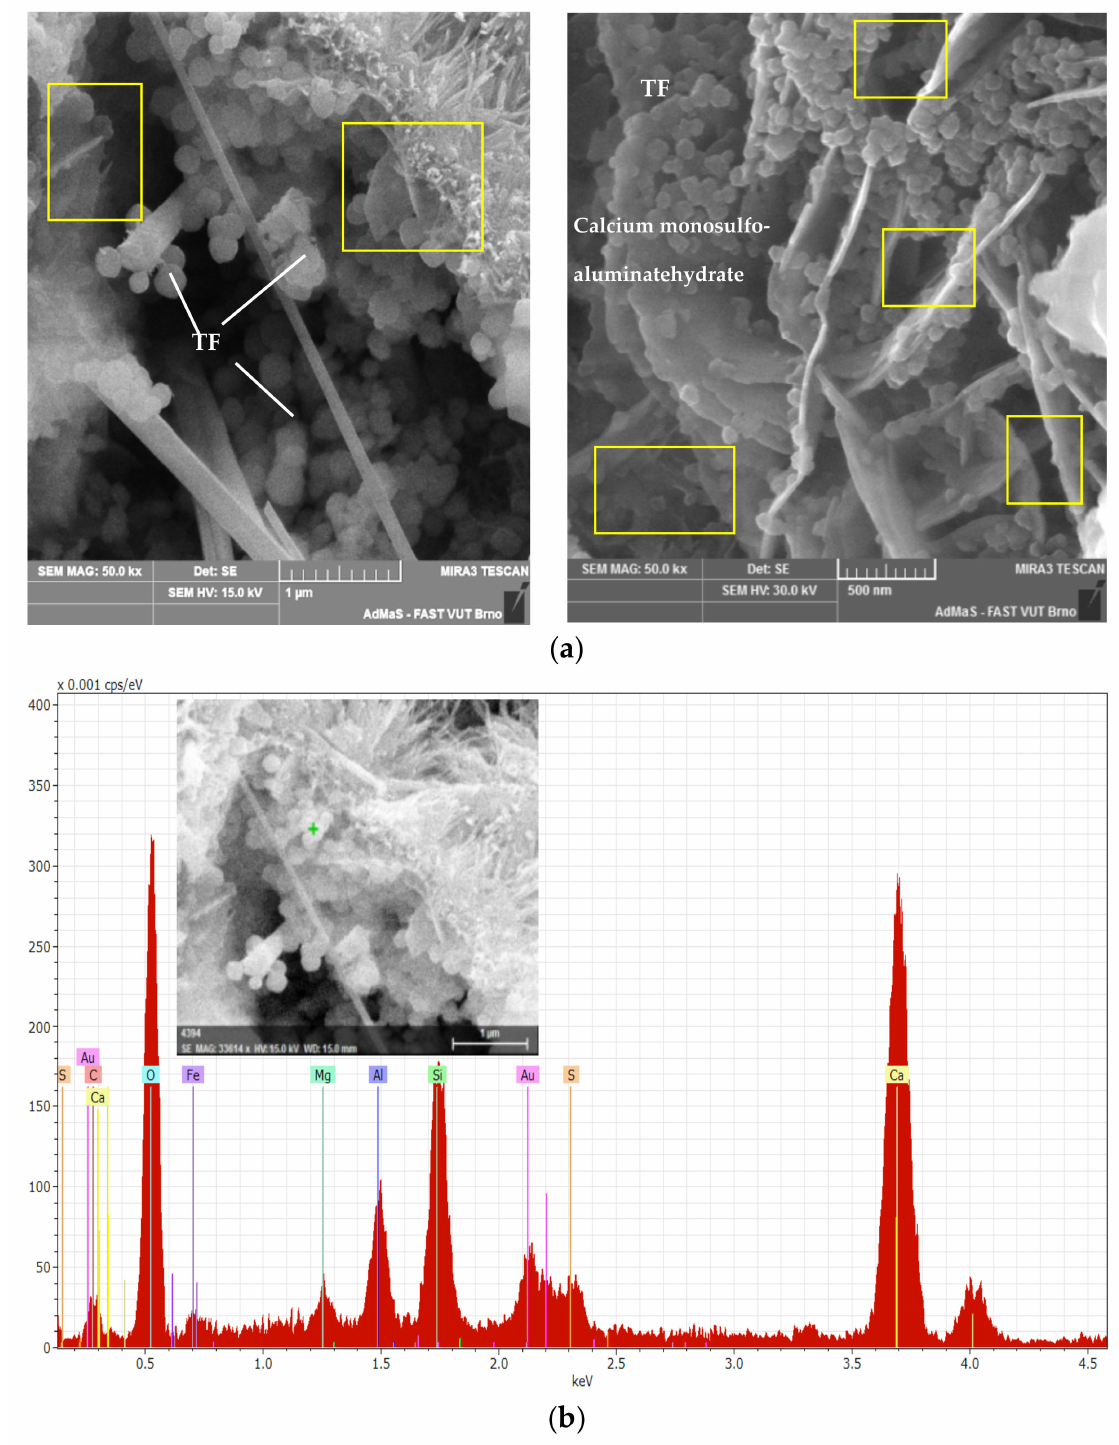
Figure 8. ( a ) Morphology of cement hydrates with carbon black at an age of 28 days. ( b ) Energy-dispersive spectroscopy